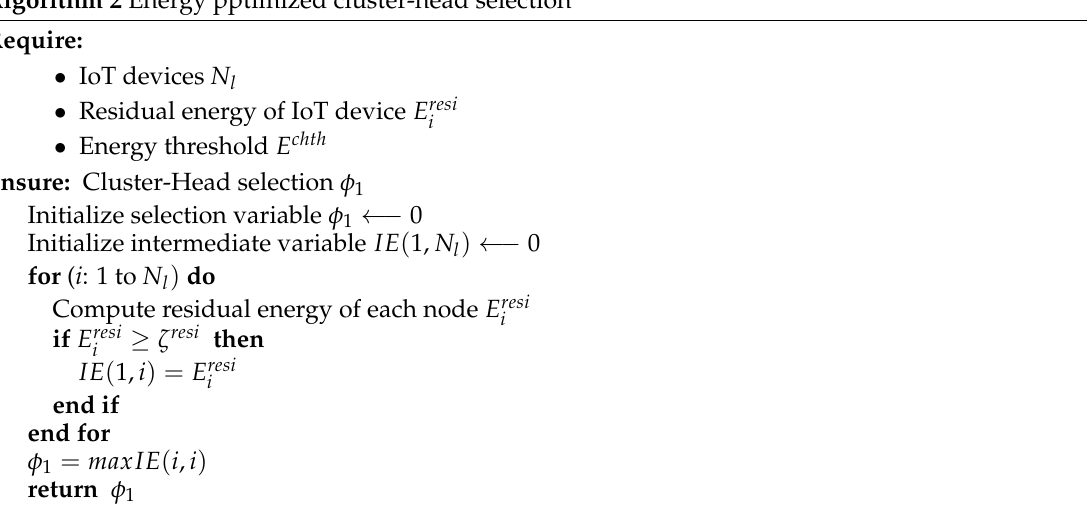
Algorithm 2 Energy pptimized cluster-head